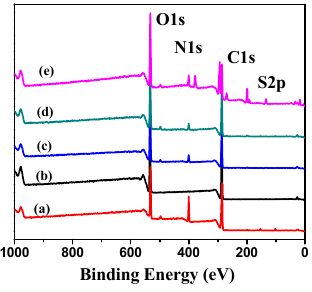
Figure 4. XPS peak fitting curves of ( a ) soy protein; ( b ) dextran; ( c ) NG1; ( d ) NG2 and ( e ) NG3.